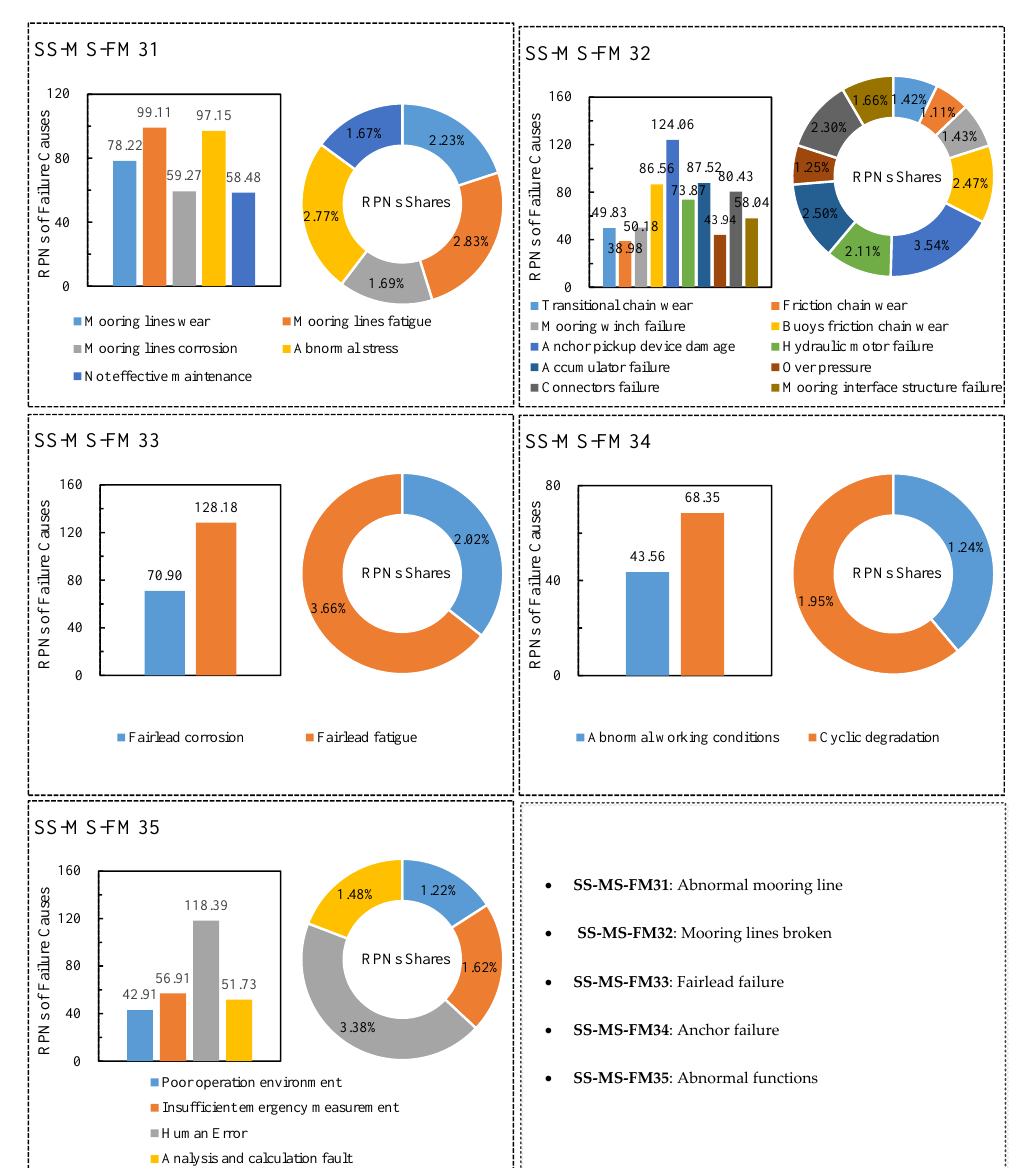
Figure 4. Failure features of the support structure at the failure mode level.